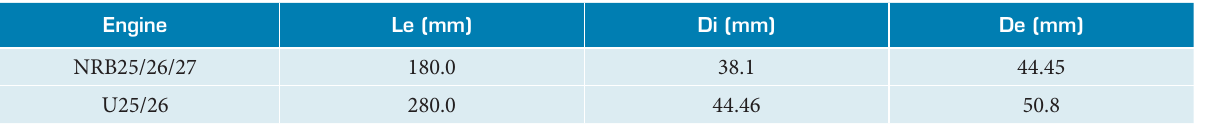
Table 2. Diameter of MTP engines.